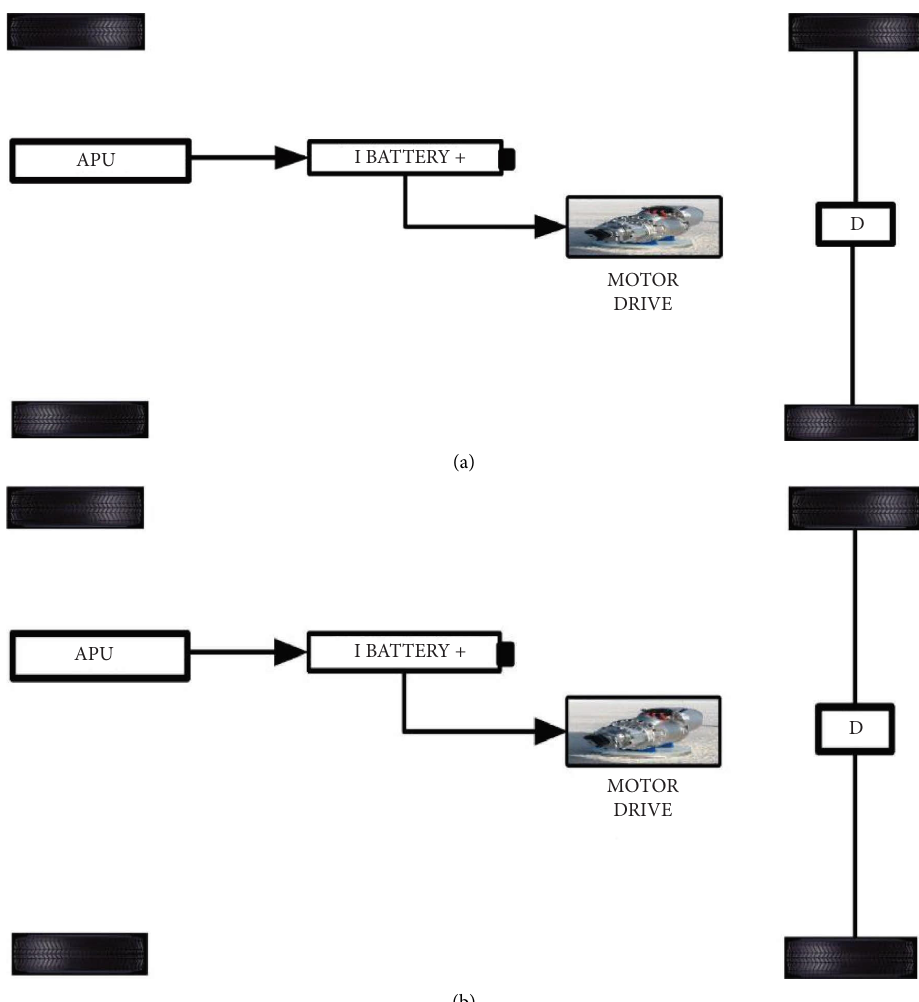
Figure 3: An EREV energy fow confguration; (a) charge sustaining period; (b) charge depleting period.